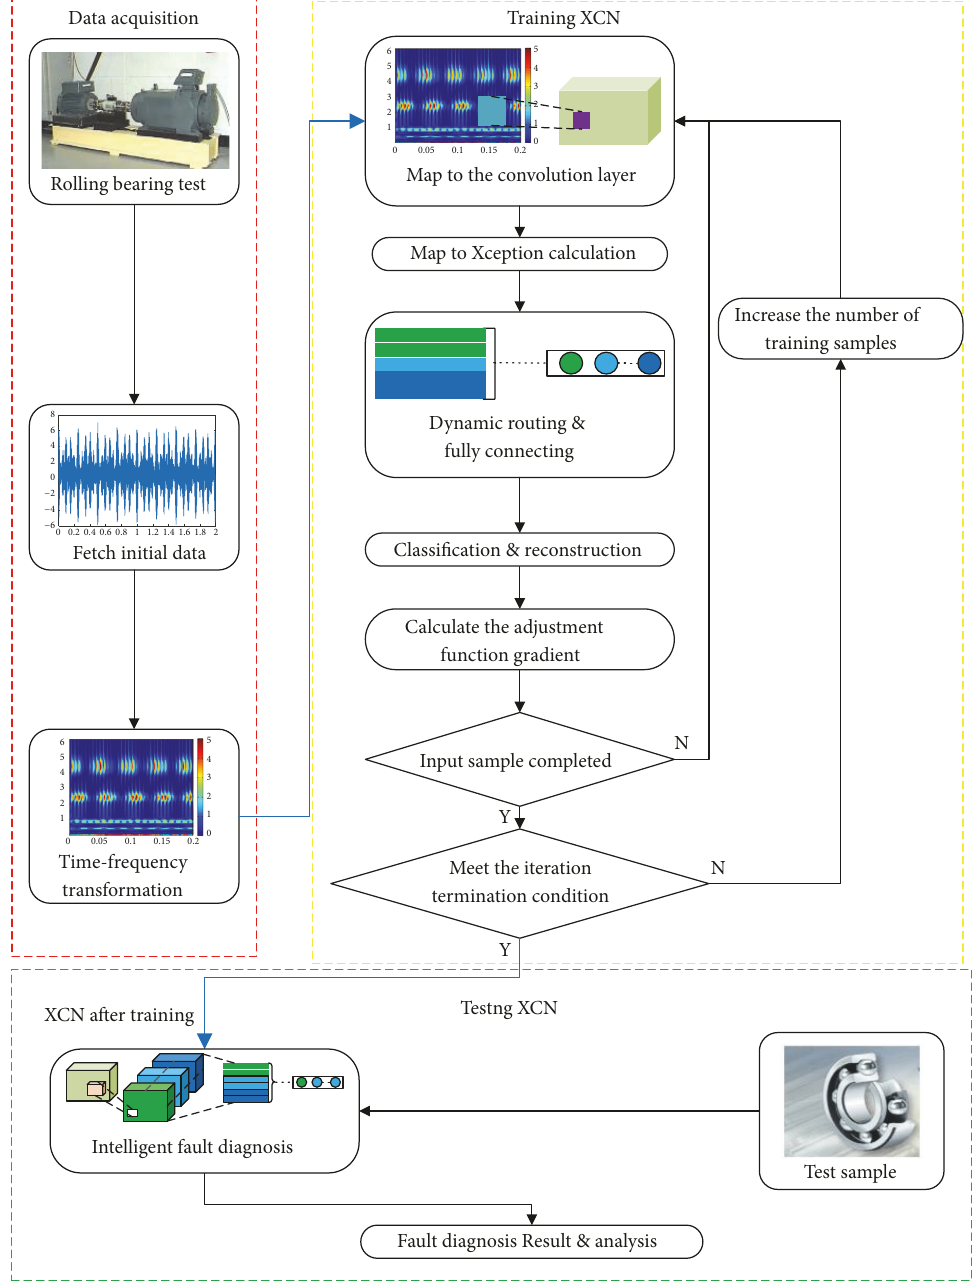
Figure 8: Intelligent fault diagnosis flow chart based on